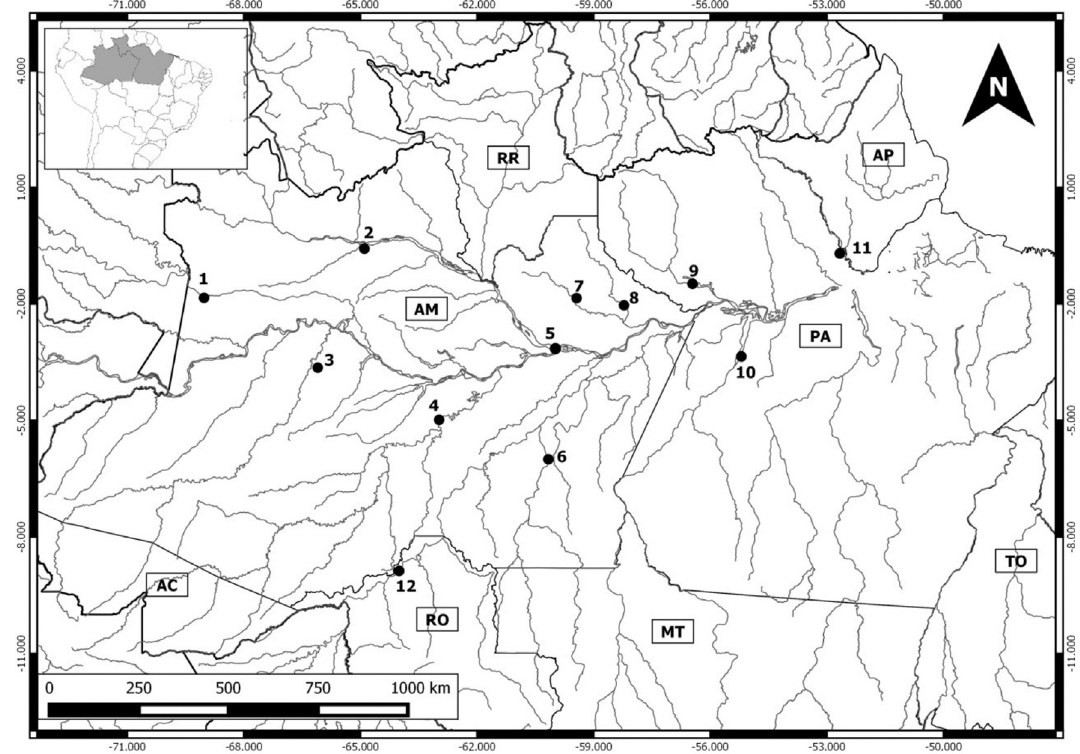
Figure 1 - Collecting sites of marsupials; the locality refers to the municipality and the access river. Collecting localities: Brazilian state of Amazonas (AM): 1- Japurá River margins, municipality of Japurá (1.843416°S, 69.026472°W); 2- Negro River margins, Santa Isabel do Rio Negro